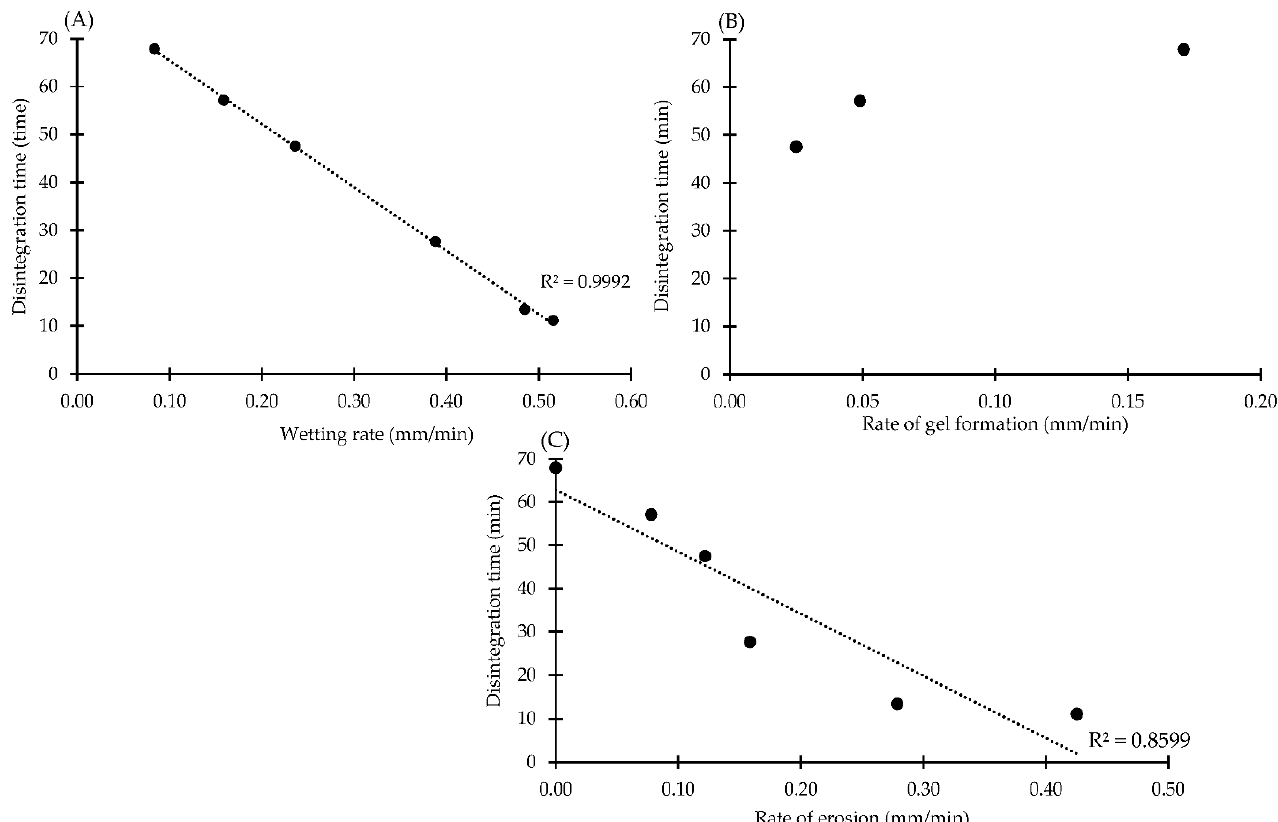
Figure 8. Correlation between rate of wetting ( A ), gel formation ( B ) and erosion ( C ) with dissolution rate of eutectic effervescent tablets in 0.1 N HCl buffer pH 1.2.